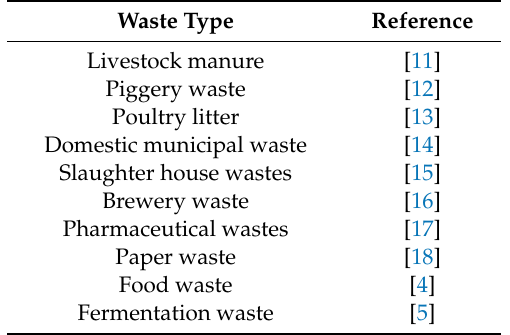
Table 1. Types of waste materials treated by ATAD processes (data adapted from